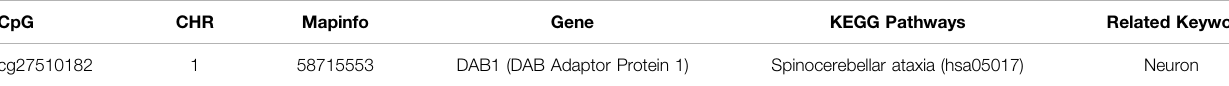
TABLE 7 | Identi fi ed genes with related keywords and pathways from KEGG database. CpG